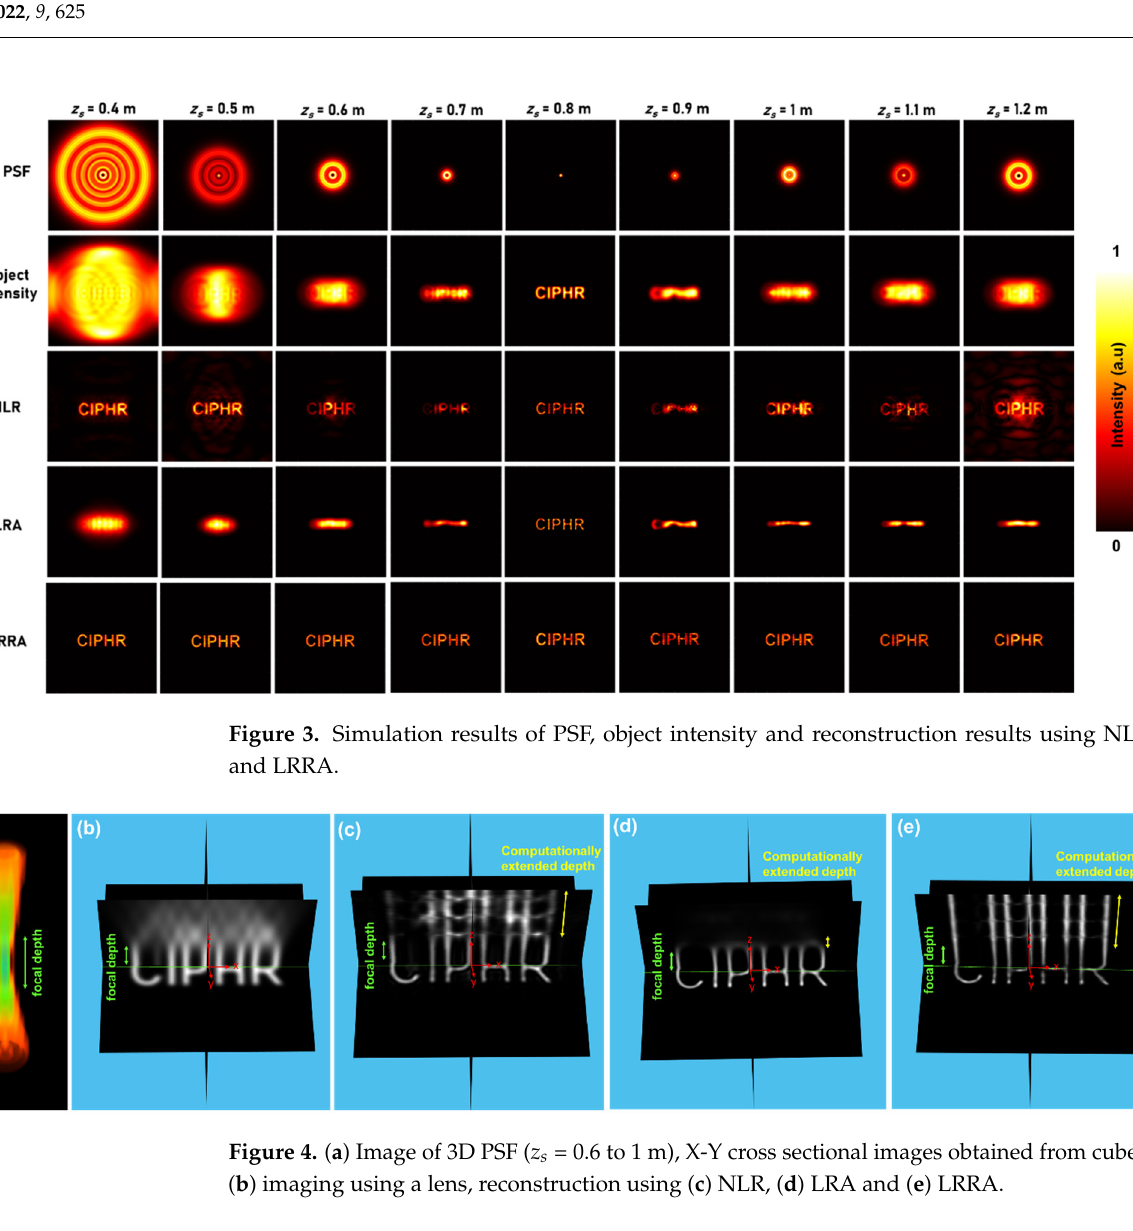
5 of 12 Figure 2. Schematic of LRRA. ML—maximum likelihood; OTF—optical transfer function; n —num- ber of iterations; ⊗ —2D convolutional operator; ℱ ∗ - refers to complex conjugate following a Fou- rier transform. 3. Simulation Studies A simulation study was carried out in MATLAB using Fresnel diffraction formula- tion. A mesh grid was created with a pixel size Δ = 10 μ m, λ = 650 nm and 500 × 500 pixels matrix. The values of z h and f were selected as 0.8 m and 0.4 m, respectively, and z s was varied from 0.4 m to 1.2 m in steps of 0.1 m. The recorded PSFs for z s = 0.4 to 1.2 m in steps of 0.1 m is shown in Figure 3. A test object ‘CIPHR’ was used, and the object intensity distributions were calculated by a convolution between the test object and the PSF. The images of the test object for different cases of axial aberrations are shown in Figure 3. The reconstruction results using LRA, NLR and LRRA are shown in Figure 3. It can be seen that the performance of LRRA is significantly better than LRA and better than NLR. The LRA and NLR had consistent reconstruction conditions such as 20 iterations and α = 0 and β = 0.6. In the case of LRRA, the conditions were changed for every case. The values of ( α , β , n ) for z s = 0.4 to 1.2 are (0,0.5,5), (0,0.5,5), (0,0.5,5), (0,0.5,5), (0,0.5,1), (0,0.5,8), (0,0.5,8), (0,0.5,8) and (0, 0.6, 5), respectively. In the case of NLR, the reconstruction improves when